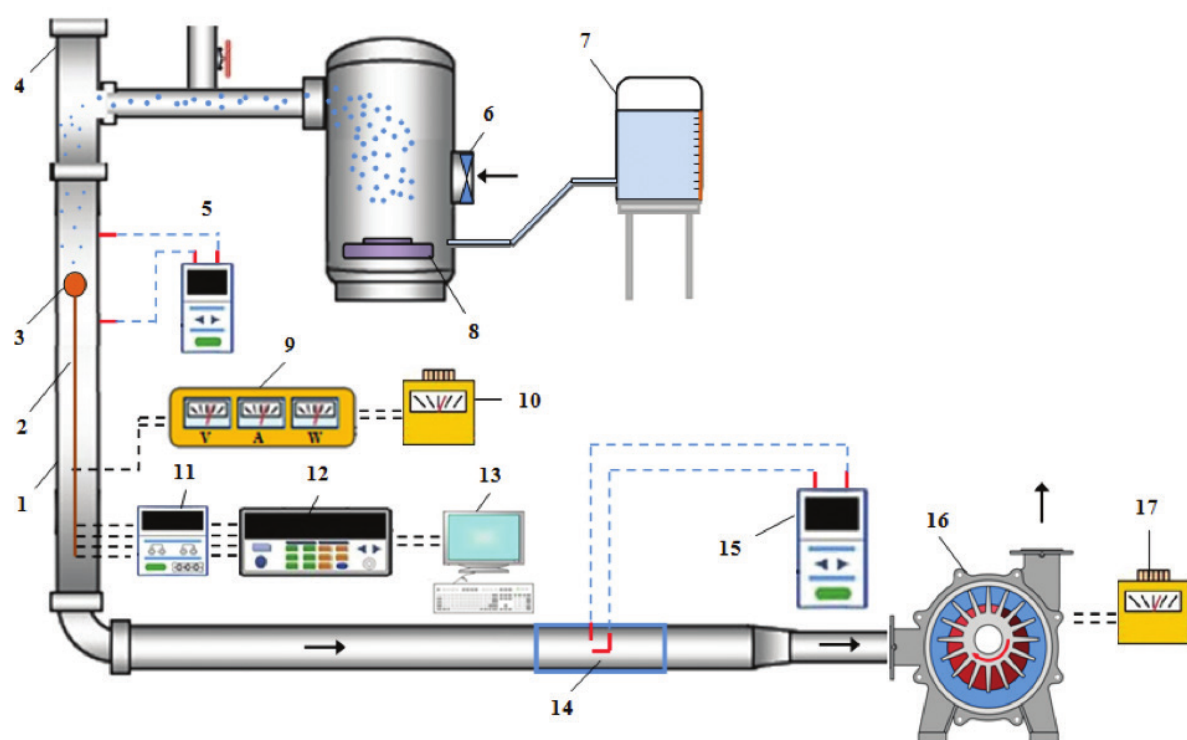
Figure 1. General layout of the experimental stand: 1 – plexiglass tube; 2 – support; 3 – copper sphere; 4 – blending chamber; 5, 15 – differential pressure gauge; 6 – fan; 7 – tank; 8 – ultrasonic mist generator; 9 – multimeter; 10, 17 – voltage controller; 11 – analogue output module; 12 – data collection module; 13 – computer; 14 – Pitot tube; 16 – air